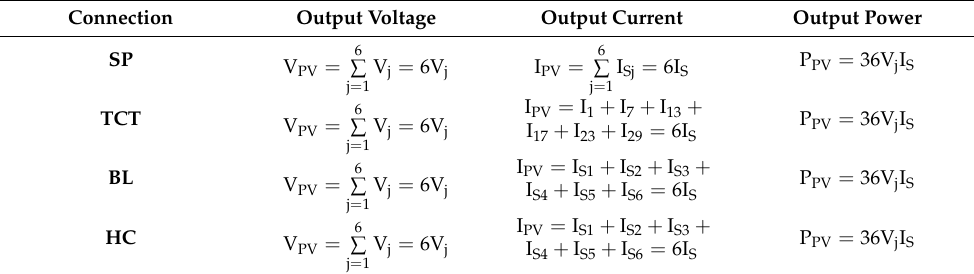
Figure 4. TCT-based MATLAB simulation for the NSD method. Table 1. The output voltage, current, and power for conventional PV array configurations.